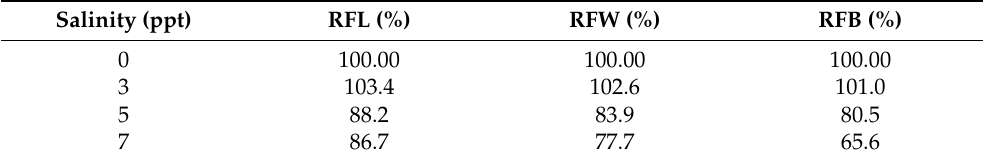
Table 2. Relative mean final length (RFL), weight (RFW), and biomass (RFB) of experimental fish were calculated assuming that final length, weight, and biomass of the control 0 ppt were 100%. Salinity (ppt) RFL